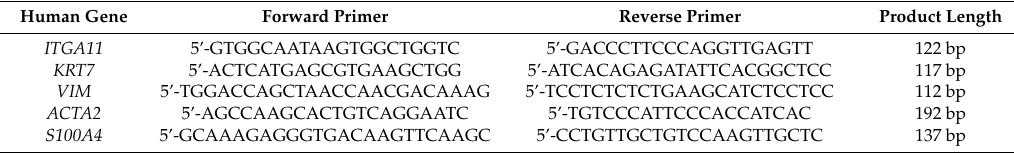
Table 3. List of Primers for the quantitative Polymerase Chain Reaction (qPCR). Human Gene Forward Primer Reverse